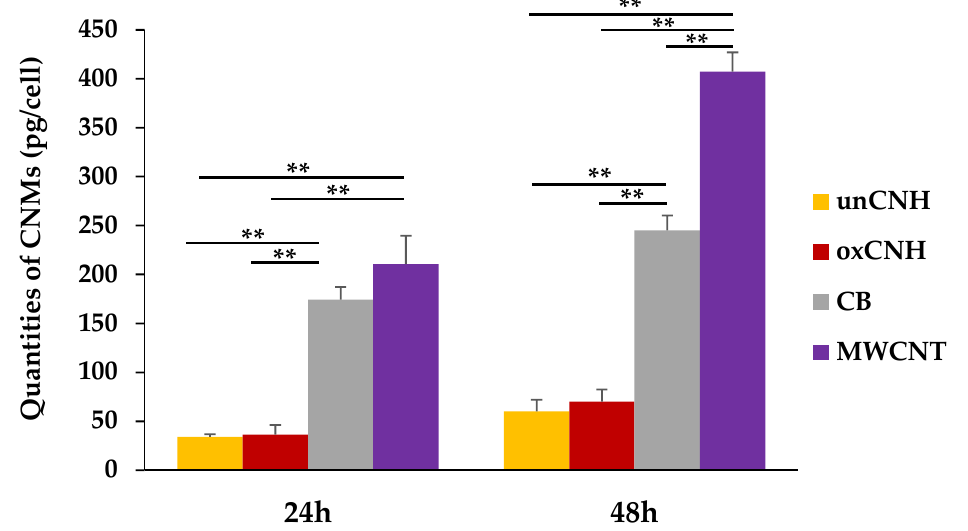
Figure 6. Uptake of each CNM per cell. HLECs were exposed to 50 µg/mL CNMs for 24 h and 48 h. Mean ± S.E. ( n = 4), ** p < 0.01. CNM, carbon nanomaterial; HLEC, human lymphatic endothelial cell;